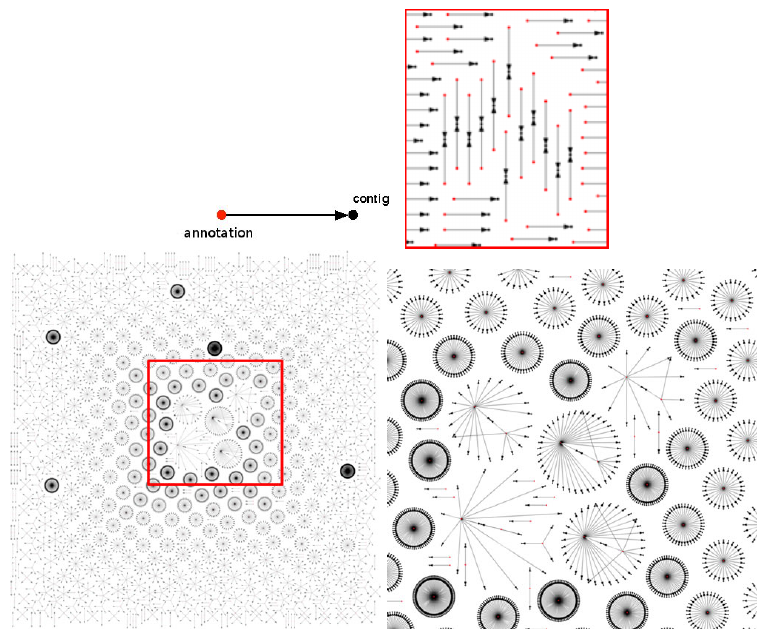
Figure 6: Vector representation of transcript-to-concept associations using the workable database from coffee. Out of 742 transcripts, only 105 had unique associations, reflecting a significant presence of gene families in the database